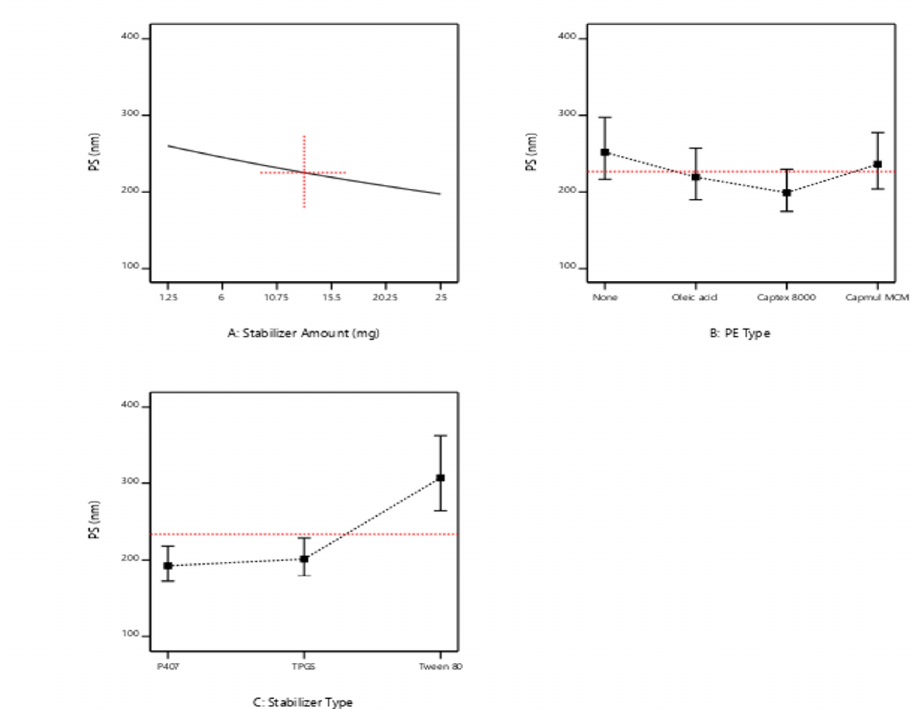
Figure 1. Main e ff ect plots showing the e ff ect of the independent variables; ( A ) stabilizer amount, ( B ) penetration enhancer type, and ( C ) stabilizer type on the particle size of the prepared